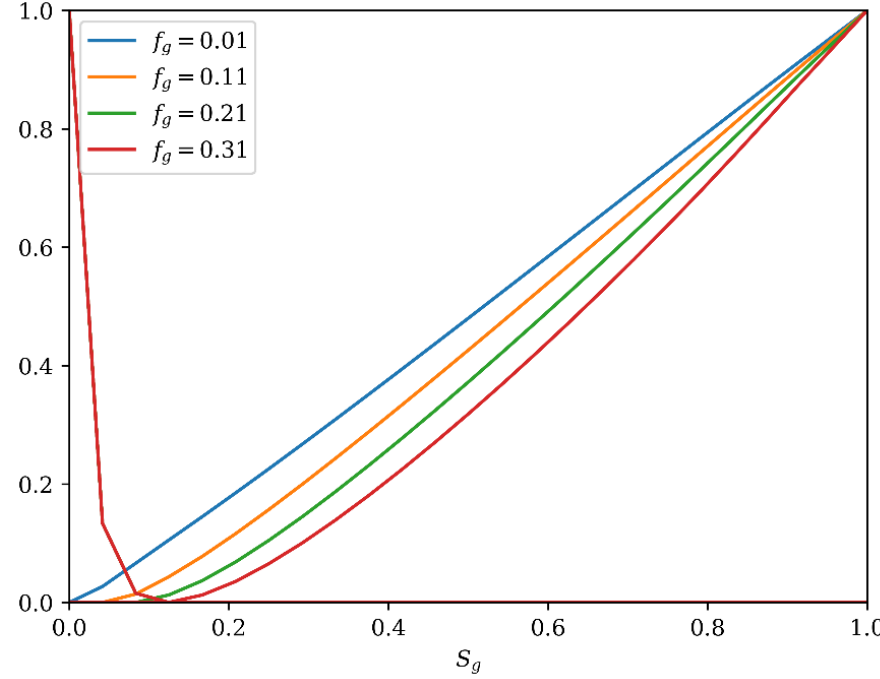
Figure 13. The sensitivity of the two-phase gas-oil relative permeabilities to changes to changes in gas threshold ratios f g , for fixed f o = 0.01, Z = 24.